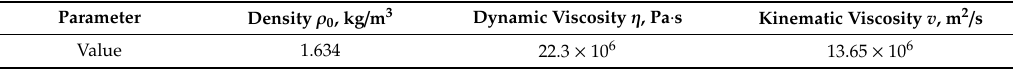
Table A1. Gas-phase flow velocity.